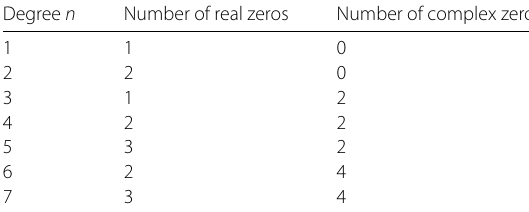
F ( c , v ) n ( x , y , z ) = 0 H ( r )